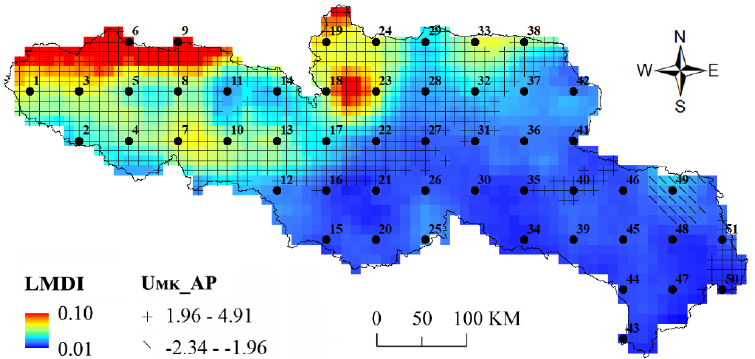
Figure 4. The spatial distribution of LMDI (long-term marginal disorder index) based on AP (annual precipitation) and the Mann–Kendall (M–K) test statistic of the AP series during 1979–2015 in the source region of the Yellow River (SRYR).